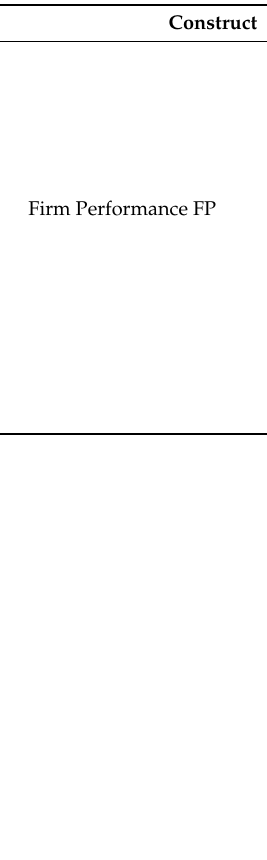
Table 3. Composite Reliability (CR), Validity Tests Results, and Descriptive